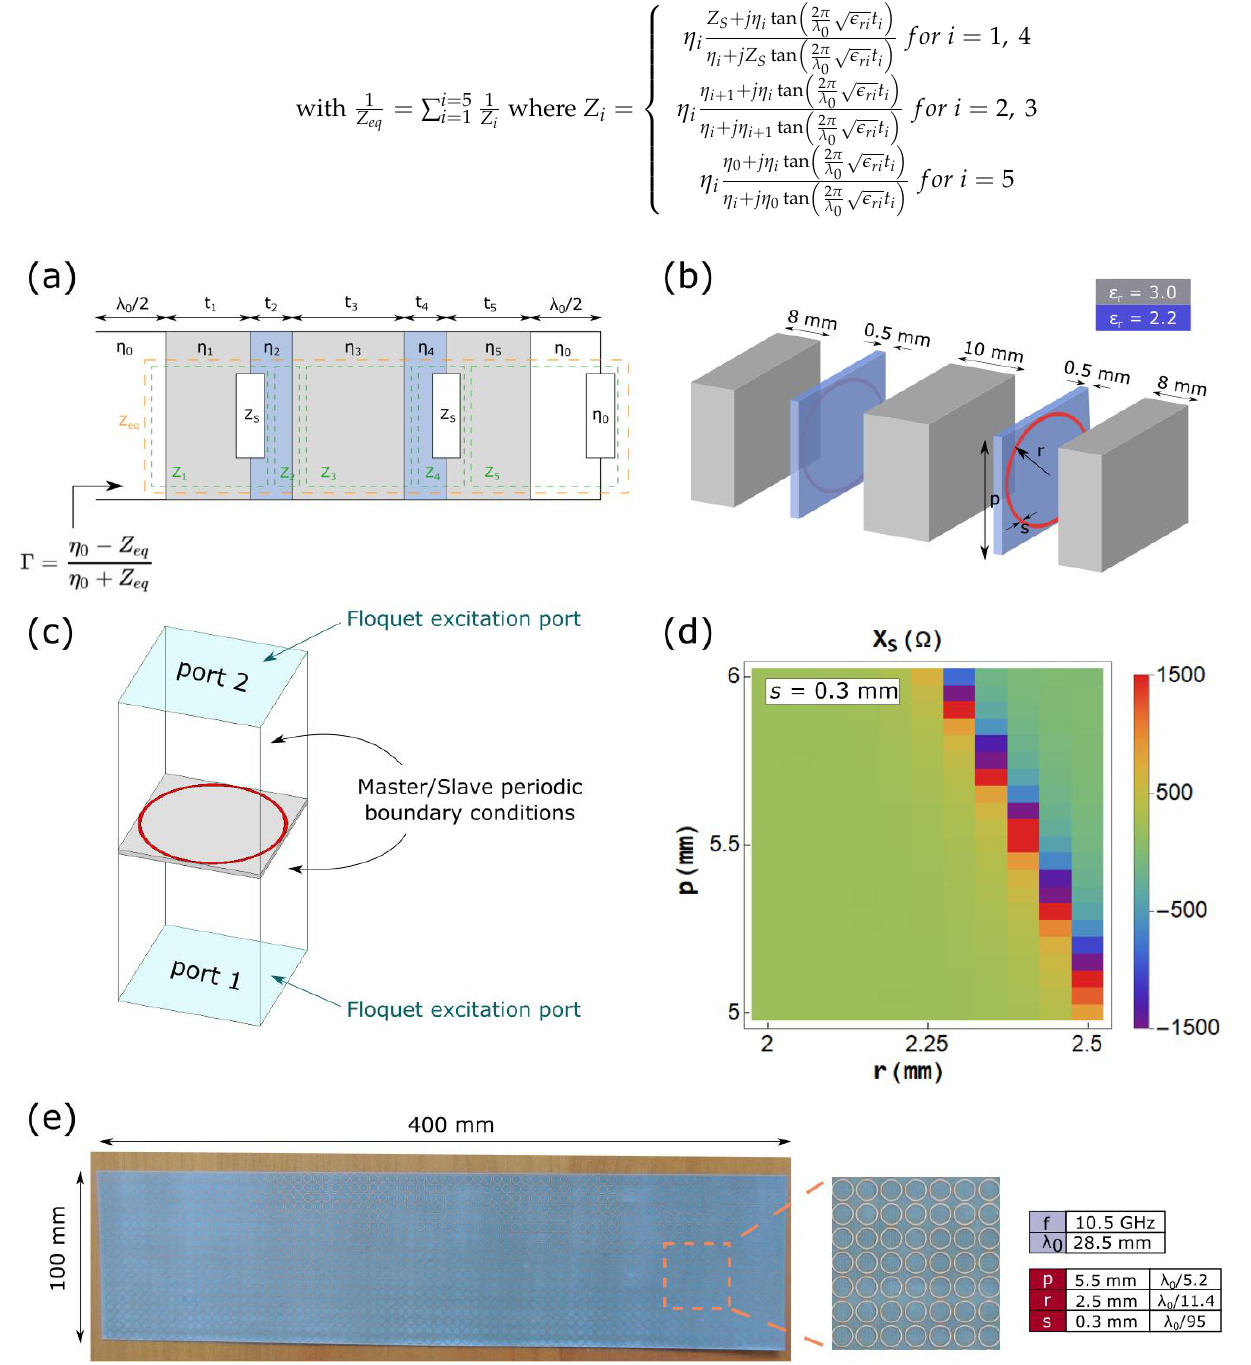
Figure 1. ( a ) Transmission line model of the metasurface-tuned seam. ( b ) Exploded view of a unit cell of the metasurface-tuned seam, comprising of three dielectric slabs ( ε r = 3.0) sandwiching two dielectric substrates ( ε r = 2.2 and tan δ = 0.001) onto which the meta-atoms are patterned. The ring meta-atom is characterized by its period p, outer radius r and width s. ( c ) Meta-atom’s simulation setup. The ring meta-atom is simulated in a periodic environment using Master/Slave boundary conditions and excited by Floquet ports. ( d ) Evolution of the reactance of a circular ring unit-cell as a function of its period p and outer radius r at 10.5 GHz. ( e ) Photography of the fabricated metasurface using printed circuit board technique with a zoom view on the unit-cells and a table giving the optimized unit-cell parameters.